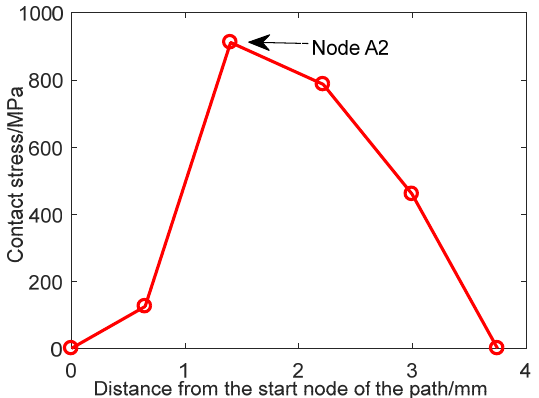
Figure 9. Axial distribution characteristics of stress on sealing surface.